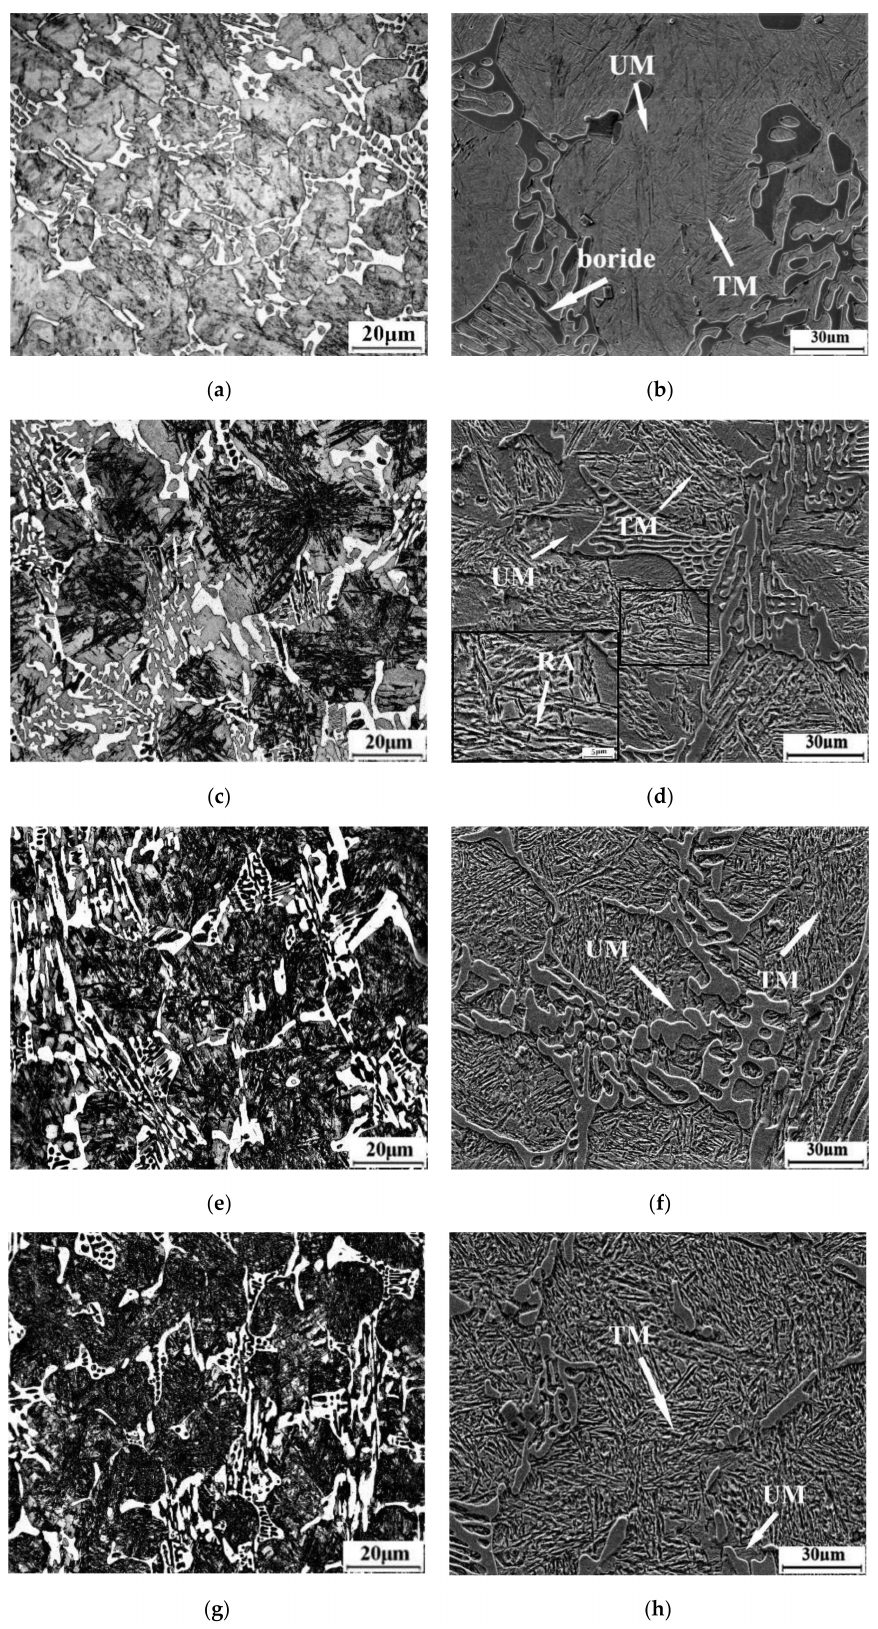
Figure 5. The microstructure of samples under different tq: ( a , b ) tq = 30 s, ( c , d ) tq = 60 s, ( e , f ) tq = 90 s, ( g , h ) tq = 120